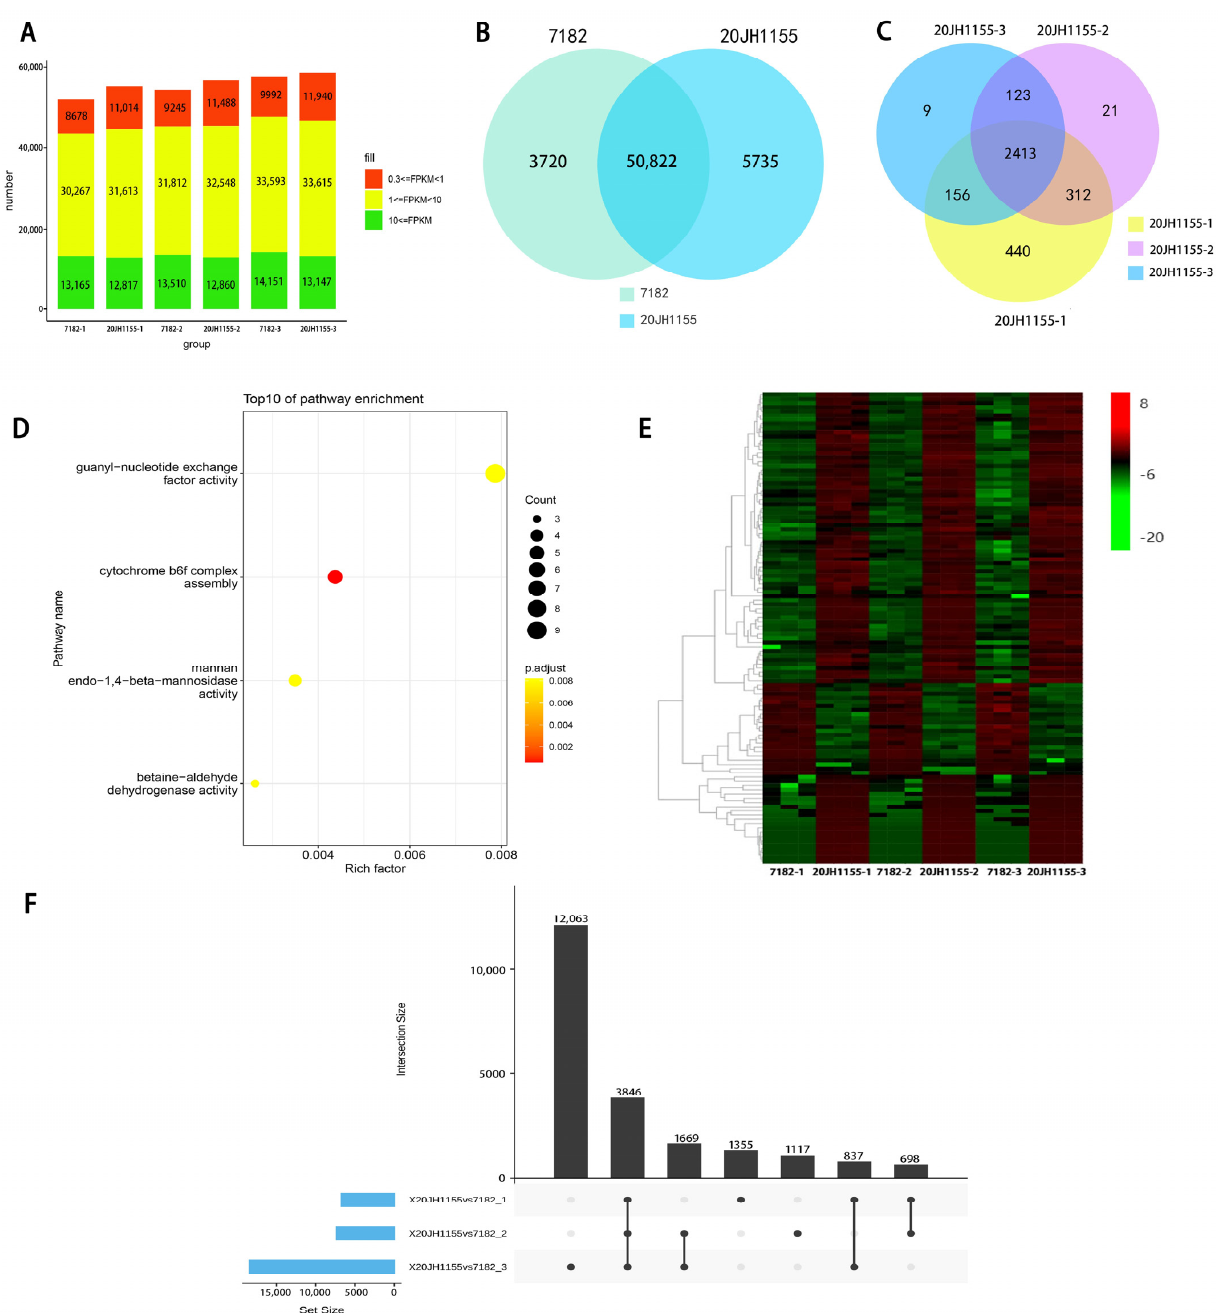
Figure 5. Transcriptome analysis of DEGs and analysis of 20JH1155 and 7182 in coregulate and expression. ( A ) Each sample has a number of genes with FPKM values of more than 0.3 from 52,110 to 58,702. ( B ) Venn-diagram of gene expression of 20JH1155 and 7182. ( C ) Venn diagram of potentially exogenous genes of 20JH1155 in three-time points. ( D ) GO enrichment analysis with potential alien genes expressing 2413 at all three time points. ( E ) The heatmap of annotated DEGs in the brown module of 18 samples. ( F ) An upset plot of DEGs overlapped in the three